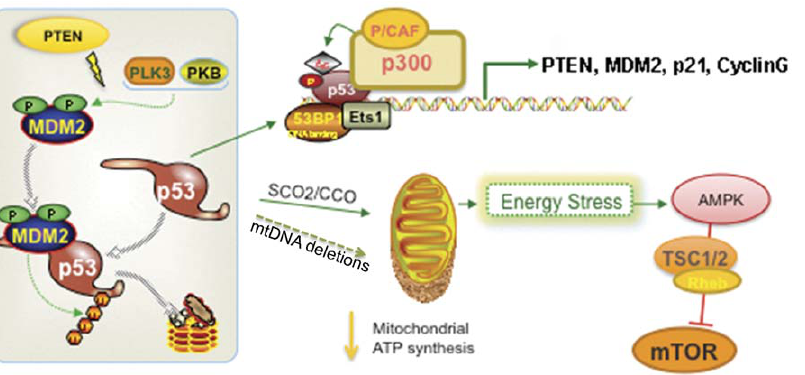
Figure 5. Interplay between Pten and p53 and energy stress response mechanism to mitochondrial dysfunction. Deficits in Pten can increase p53 degradation via Akt-mediated phosphorylation of MDM2 or by a feedback loop. Decreased levels of p53 leads to decreased levels of its downstream effectors (p21 and SCO2), subsequent CCO deficiency, leading to increased oxidative stress and energy deficits (this and other reports [44]). This would elicit the energy stress-mediated mTOR activation with consequent brain hypertrophy as observed in our haplo-insufficient Pten mice as well as in the null mice models. Accumulation of mtDNA deletions (see Figure 4 ) may also ensue in MD contributing to the pathogenesis.